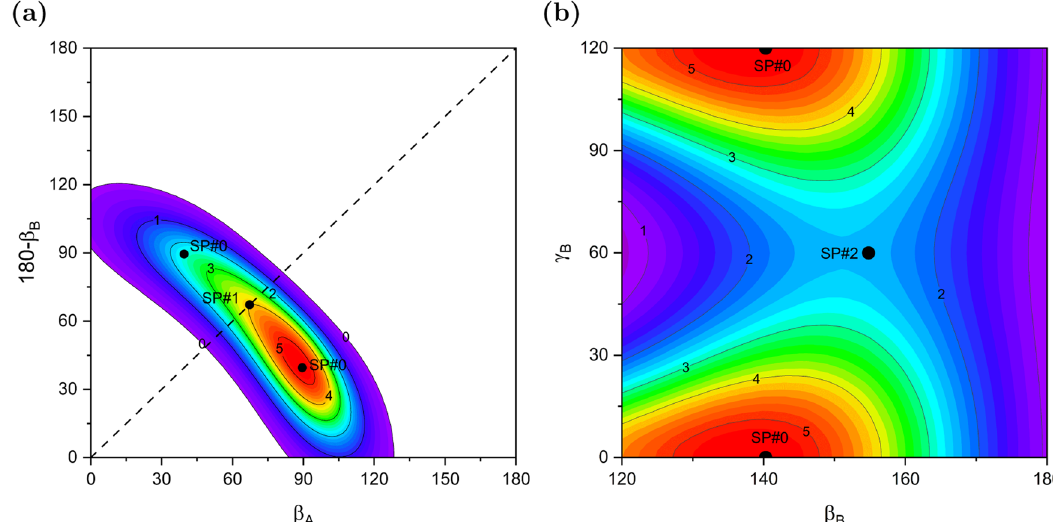
Fig. 5 NH 3 – NH 3 ground-state wave function of G symmetry. The absolute value squared is plotted in bohr − 3 . Panel a shows the region of the interchange path through SP#1 for which the PES is shown in Fig. 2a. Panel b shows the SP#2 region for which the PES is shown in Fig. 2b. Note that the optimized values of β A are chosen to be around 90°, so that the wave function in panel b contains (twice) the highest maximum shown in panel a with 180° − β B ≈